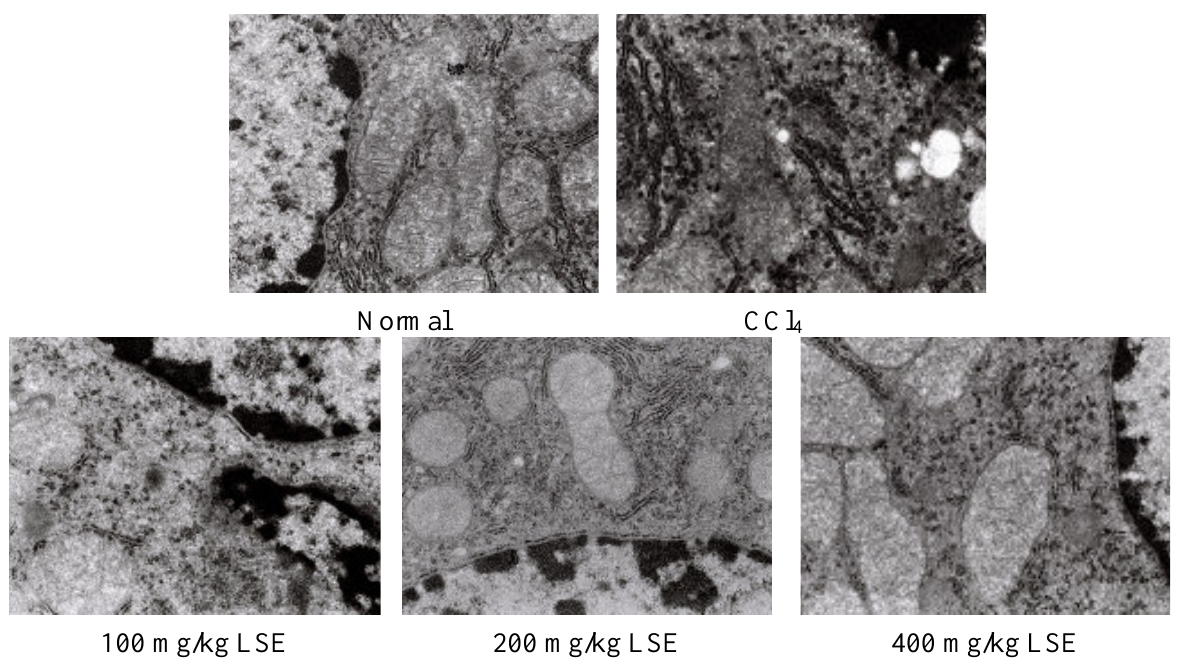
Figure 2. Effect of LSE on the ultrastructure of hepatocytes insulted by CCl